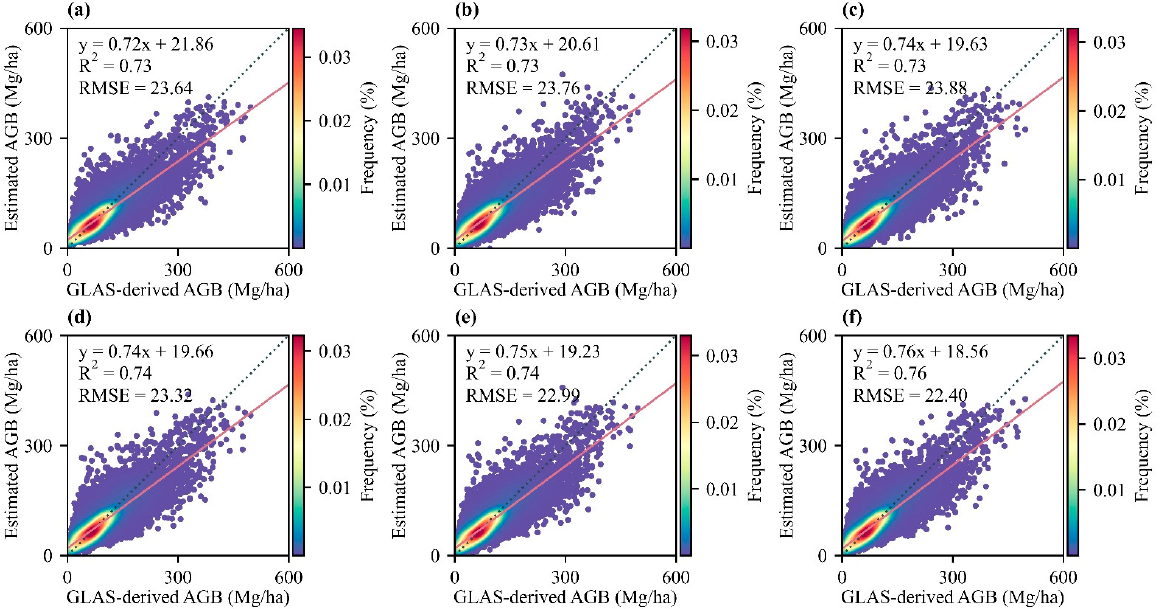
Figure 2. Performance of the six models in the cross-validation. The dotted lines and red lines are 1:1 line and fitting line, respectively. ( a ) RF, ( b ) GB, ( c ) XGB, ( d ) LGBM, ( e ) CatBoost, and ( f ) Stacked.